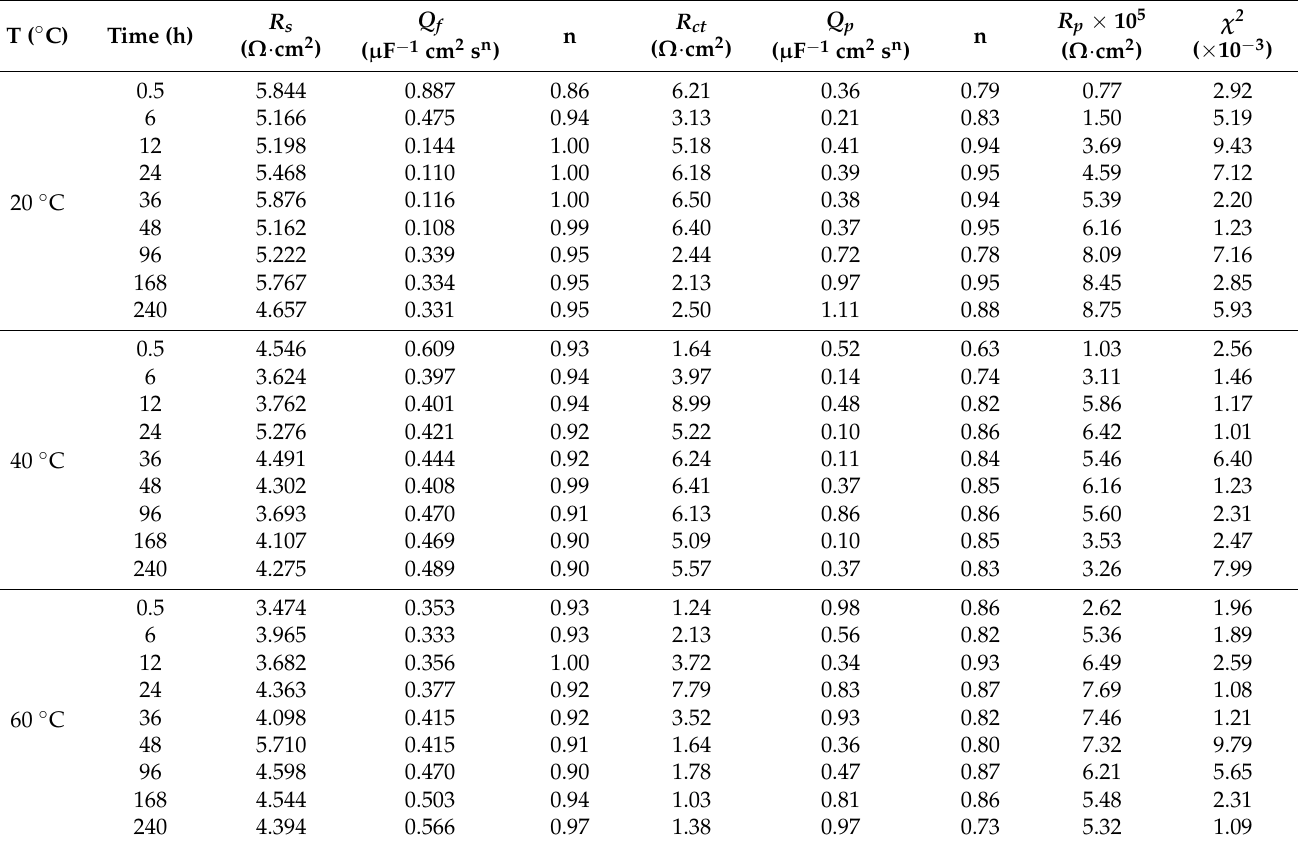
Table 3. EIS fitting parameters of Q235 carbon steel at different temperatures and passivation